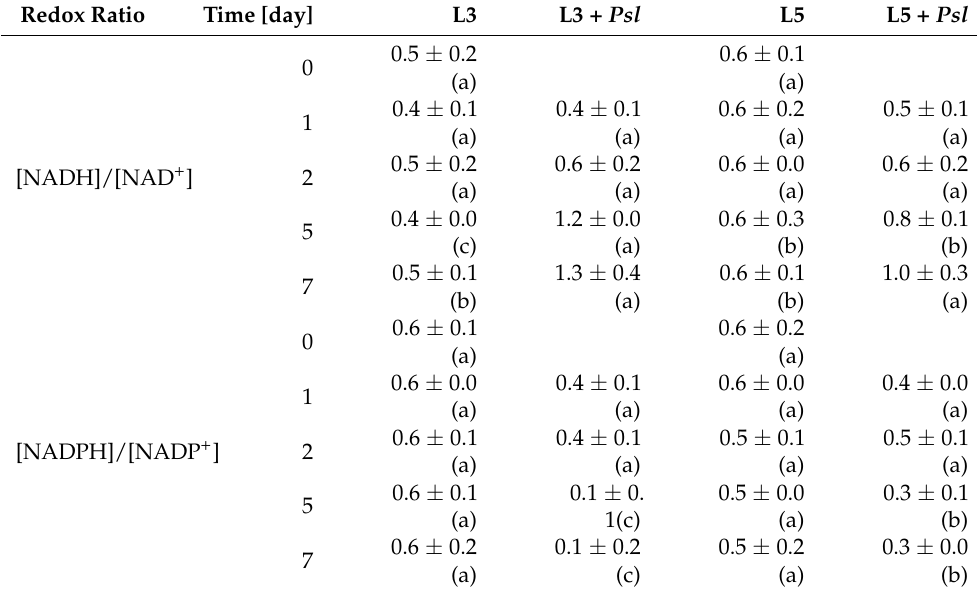
Table A1. Nicotinamide adenine dinucleotides redox ratios in cucumber leaves after Pseudomonas syringae pv lachrymans infection.